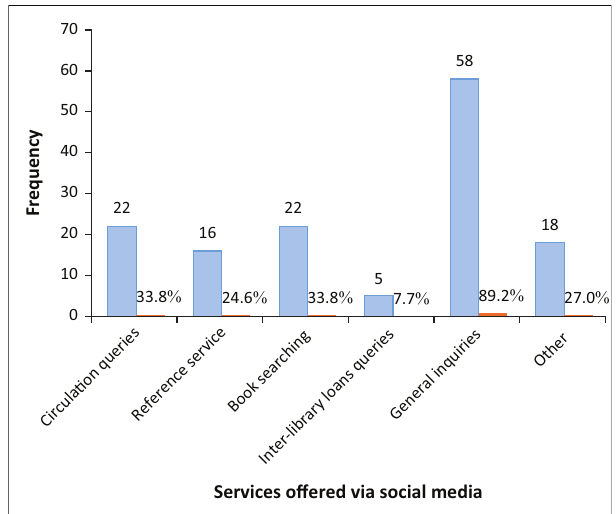
FIGURE 3: Types of services offered on social media page(s) ( n =